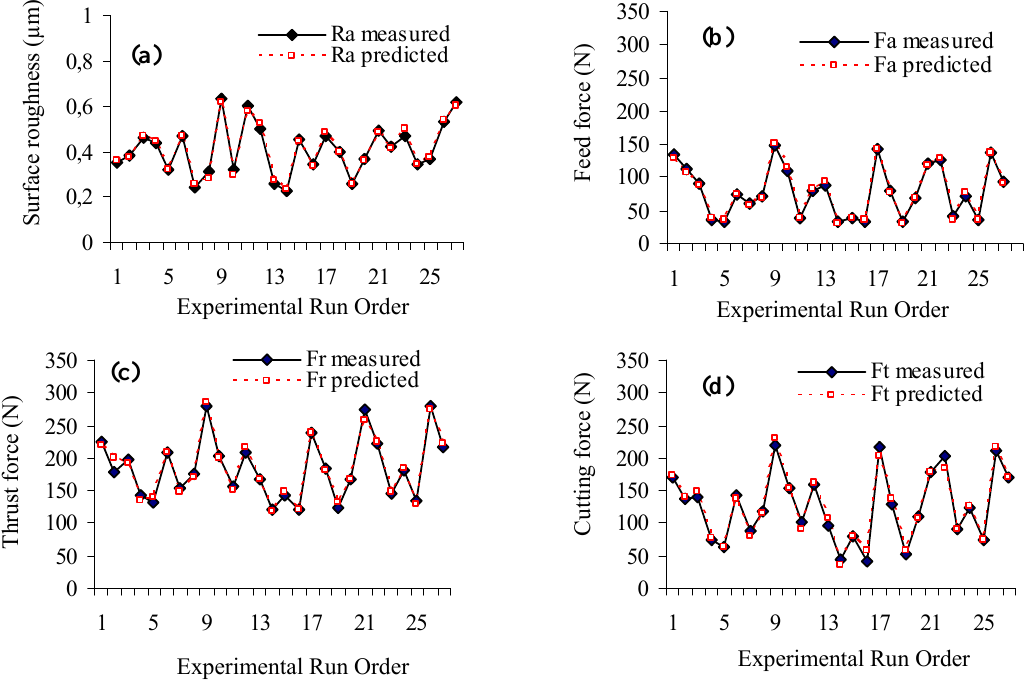
Fig.8. (a) The comparison between measured and predicted value of Ra and (b), (c), (d) comparison between measured and predicted value of Fa , Fr and Ft respectively